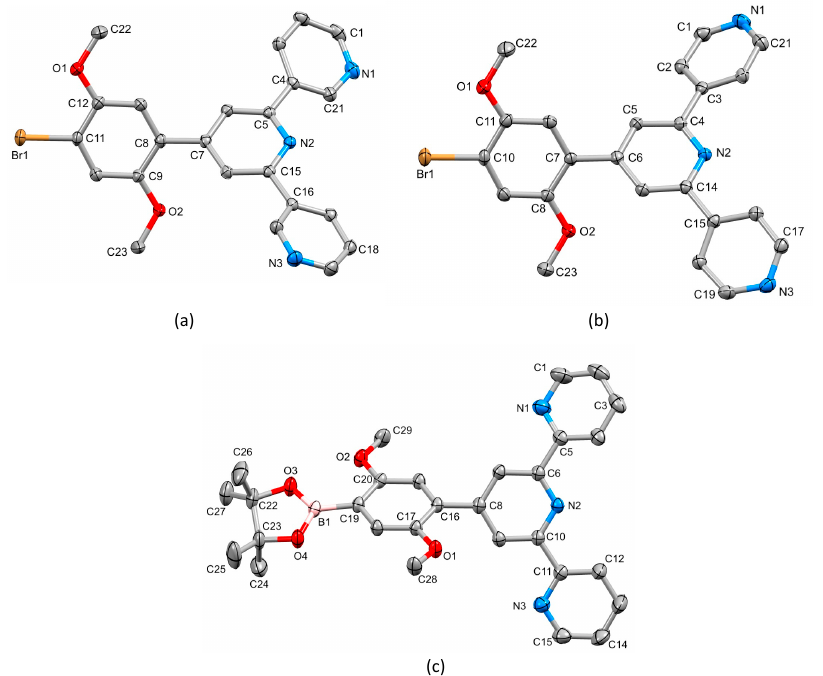
Figure 4. The structures of ( a ) 3 , ( b ) 4 and ( c ) 2 with ellipsoids plotted at 50% probability level and H atoms omitted for clarity. Selected bond parameters: in 3 : C11–Br1 = 1.8950(16) Å, C12–O1 =